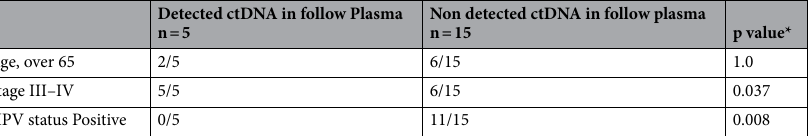
Table 3. Association of clinical factors with the presence or absence of ctDNA detection in follow plasma. *Fisher’s test. Patient